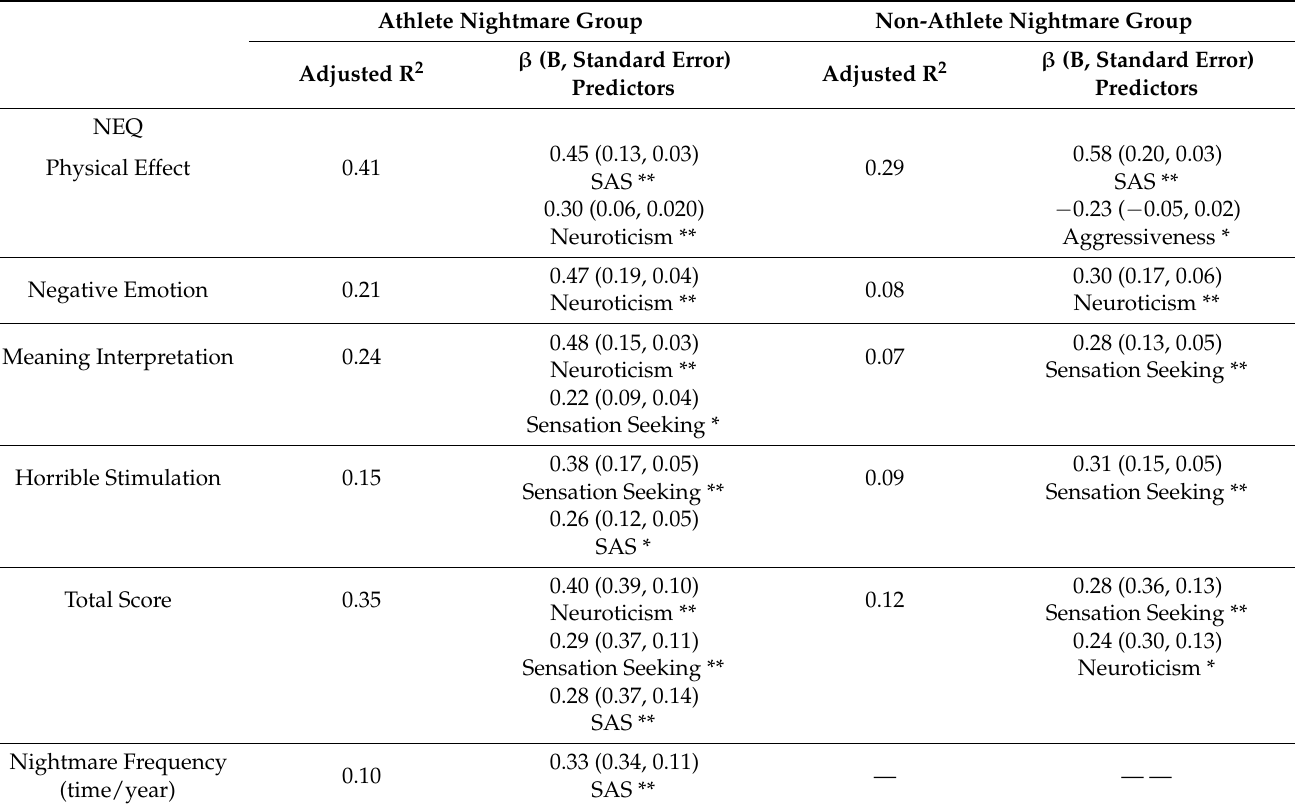
Table 5. Stepwise multiple linear regression for predicting NEQ from SAS and ZKA/PQ-SF scales in athlete nightmare group (n = 87) and non-athlete nightmare group (n =